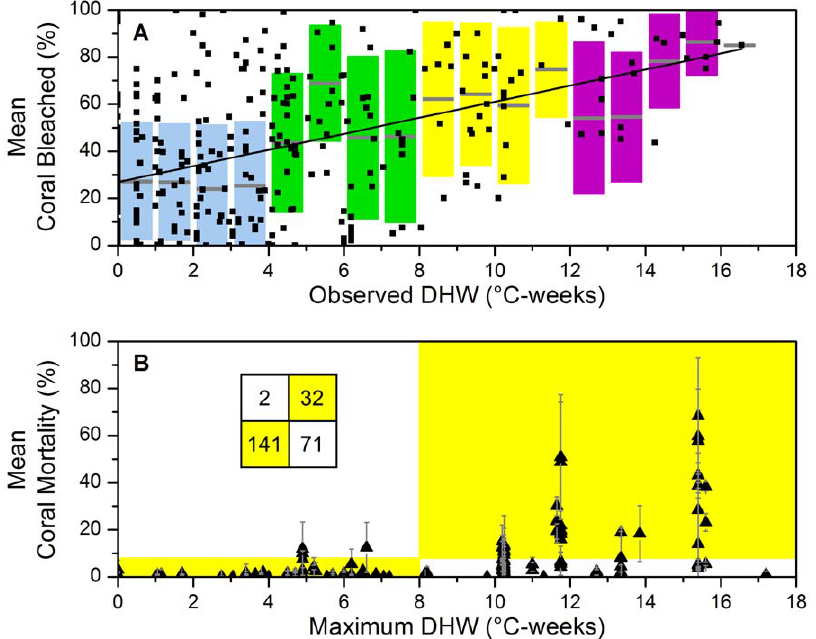
Figure 3. Mean coral bleaching and mortality versus thermal stress. (A) Small squares represent mean percent coral bleached (by area or colony) for each 0.5-degree pixel and twice-weekly time period plotted against observed DHW value. Solid line indicates significant linear regression ( slope =3.41, intercept =26.94, DF =359, p , 0.0001, r 2 =0.24). Colored bars indicate mean (gray bar) and standard deviation of all surveys binned at 1 u C-week intervals; colors correspond to low bleaching risk (DHW , 4, blue), moderate risk (DHW $ 4, green), high bleaching and mortality risk (DHW $ 8, yellow), and very high risk (DHW $ 12, purple). (B) Triangles represent mean percent coral mortality ( 6 standard deviation) reported during 25- Jul-2005 to 20-Jan-2007, plotted against the 2005 maximum DHW value recorded for each 0.5-degree pixel. Yellow and white areas correspond to the inset box where values indicate number of data points in each quadrant (quadrants defined as 0 # DHW , 8 and 0 # mortality , 8%; 0 # DHW , 8 and 8% # mortality; 8 # DHW and 0 # mortality , 8%; 8 # DHW and 8% #